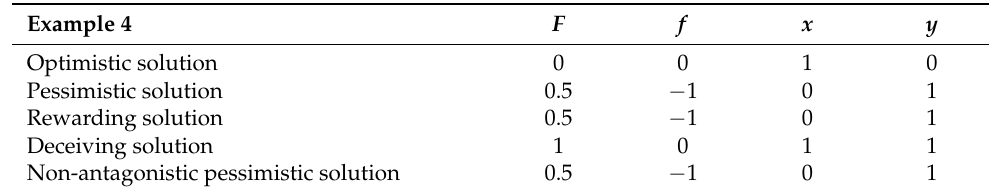
Table 4. The solutions and optimal values of Example